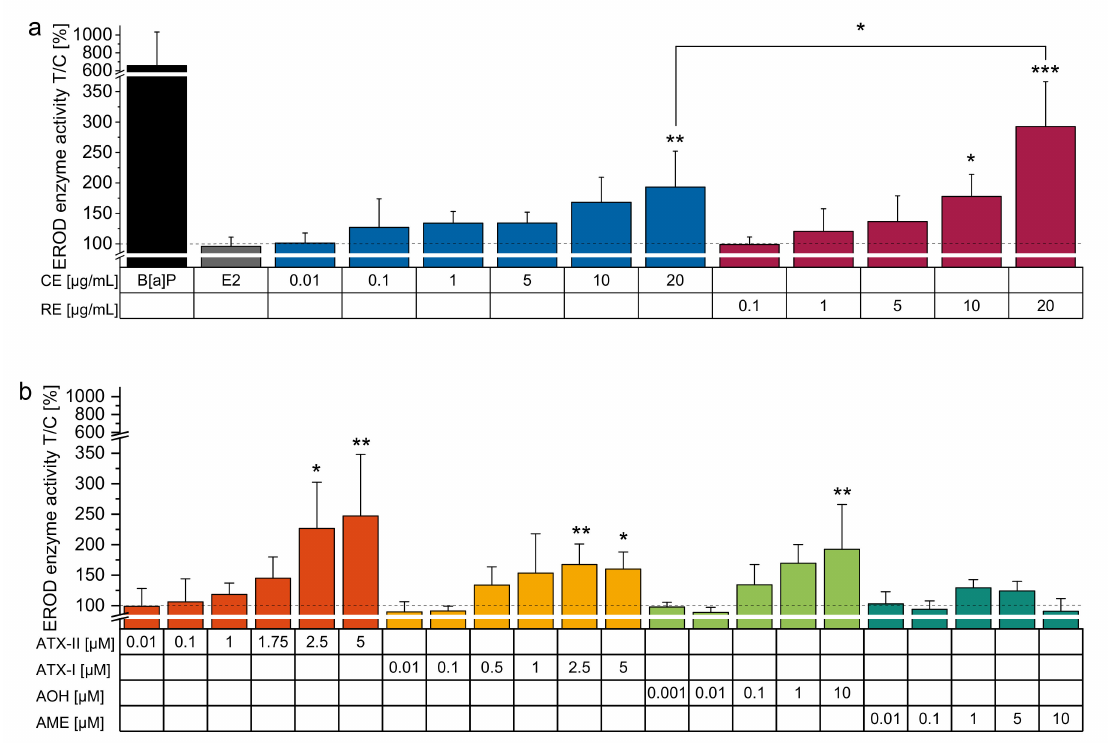
Figure 2. EROD assays with Alternaria extracts and single toxins. Enzyme activity measurements (pmol resorufin / mg protein*min) presented as means + SD normalized to solvent control (1% DMSO) of at least 3 individual experiments. Enhancement of EROD enzyme activity after 24 h of incubation applying ( a ) B[a]P (1 µ M), E2 (1 nM), CE (0.01 µ g / mL–20 µ g / mL), RE (0.1 µ g / mL–20 µ g / mL) and ( b